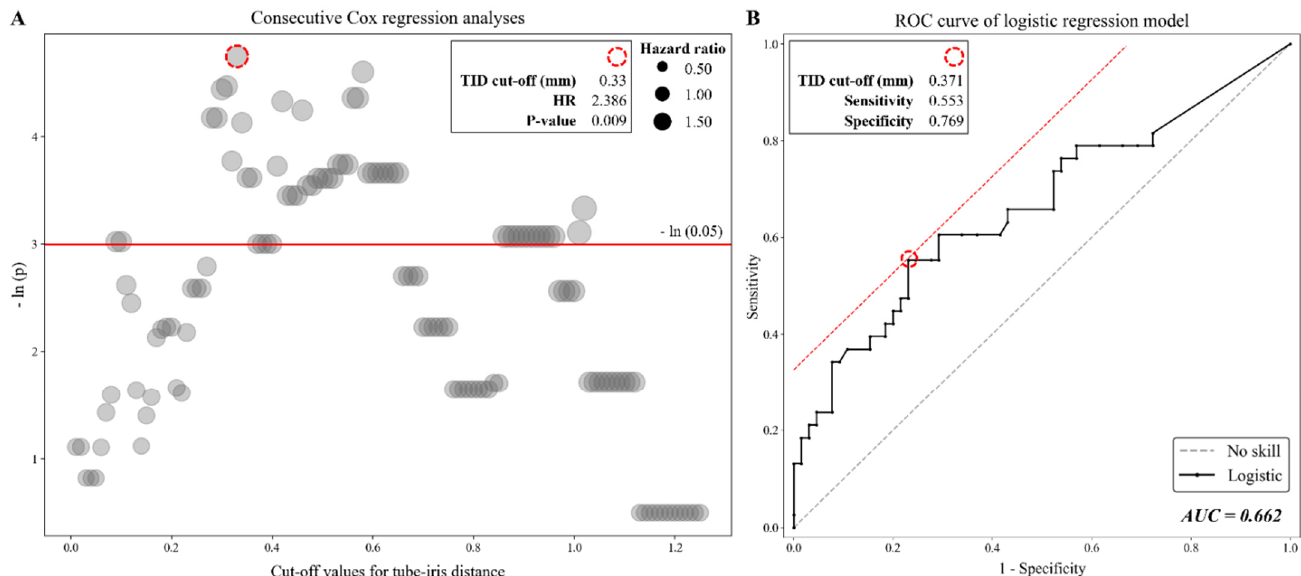
Figure 2. Determination of the optimal cut-off value regarding the tube–iris distance (TID). Consec- utive Cox regression analyses were conducted for every potential cut-off value between 0.01 mm and 1.25 mm at 0.01 mm intervals. The x-axis indicates the evaluated TID cut-off values, the